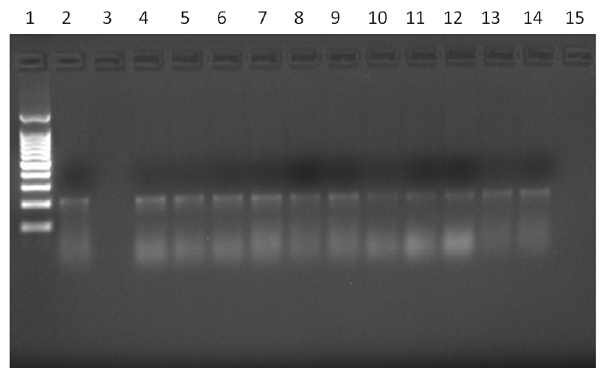
Figure 4. Agarose gel electrophoresis showing PCR positivity of eleven patients with confirmed cases of AA. Lane 1: Molecular weight markers (100-pb ladder). Lane 2: DNA from Angiostrongylus costaricensis (positive control). Lane 3: Negative control. Lane 4–14 Confirmed cases with respective DNA concentrations: 12.2 m g/mL; 9.5 m g/mL; 6.5 m g/mL; 11.6 m g/mL; 4.43 m g/mL; 8.88 m g/mL; 1.17 m g/ mL; 1.48 m g/mL; 2.28 m g/mL; 2.4 m g/mL; 5.28 m g/mL. Lane 15: Mix (reaction control for detection of possible contaminants).